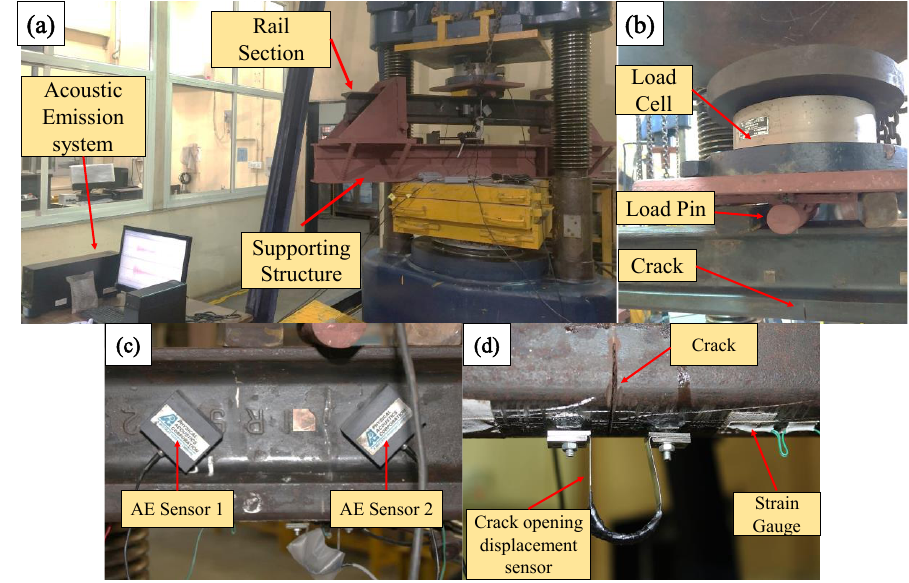
Figure 5. Pictures for actual experimental setup ( a ) Three-point bending setup and acoustic emission system ( b ) Loading arrangement ( c ) Acoustic emission sensor ( d ) Crack and crack opening displacement sensor.